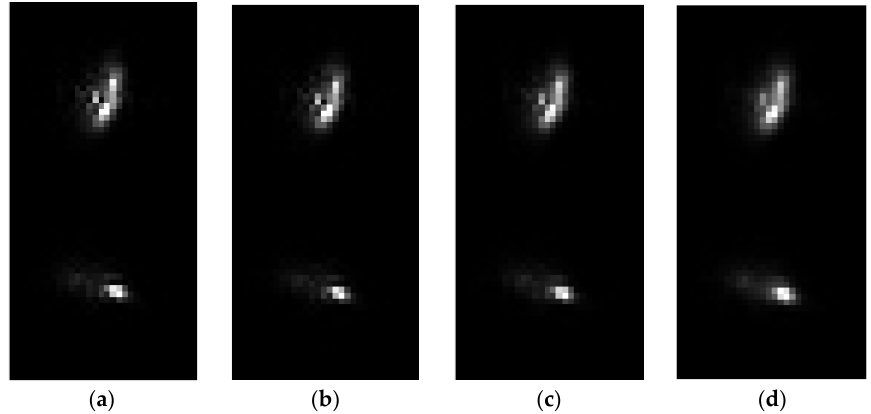
Figure 4. Four pairs of simulated PSF images in the presence of different jitter parameters for the same wavefront error and noise level. ( a ) shows a pair of PSFs without jitter. The magnitudes of jitter in ( b – d ) are 0.1 pixels, 0.3 pixels, and 0.5 pixels, respectively. We can see that, as the magnitudes of jitter increases, the PSF images become vague. Table 1. Comparison of traditional phase retrieval algorithms which do not take jitter into consid- eration (A1, B1) and the two jitter-robust phase retrieval approaches (A2, B2) for the PSF pairs in Figure